Question: According to the figure, is the described quantity increasing or decreasing?
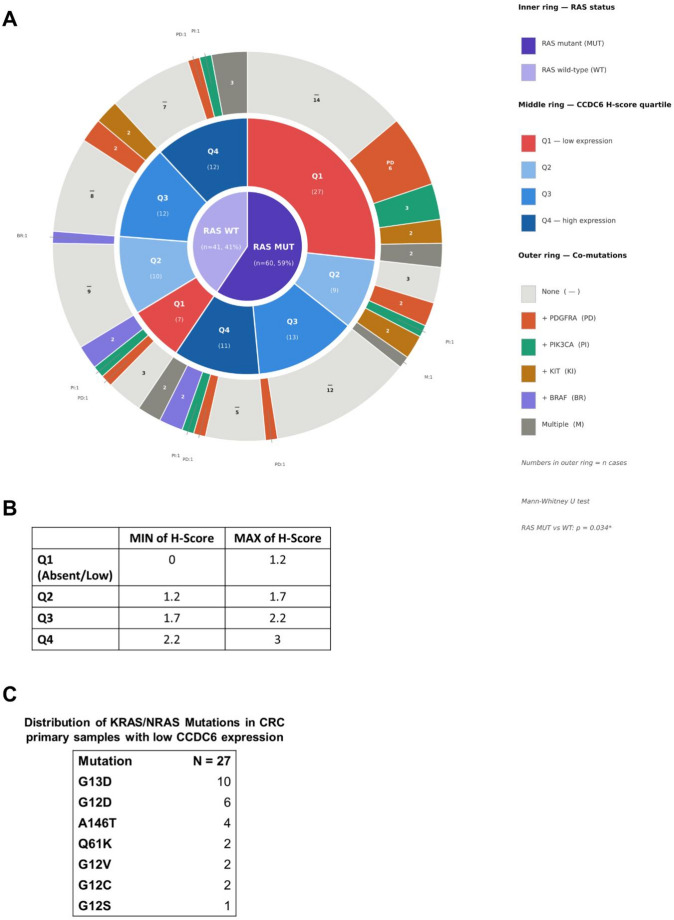
Answer: increasing